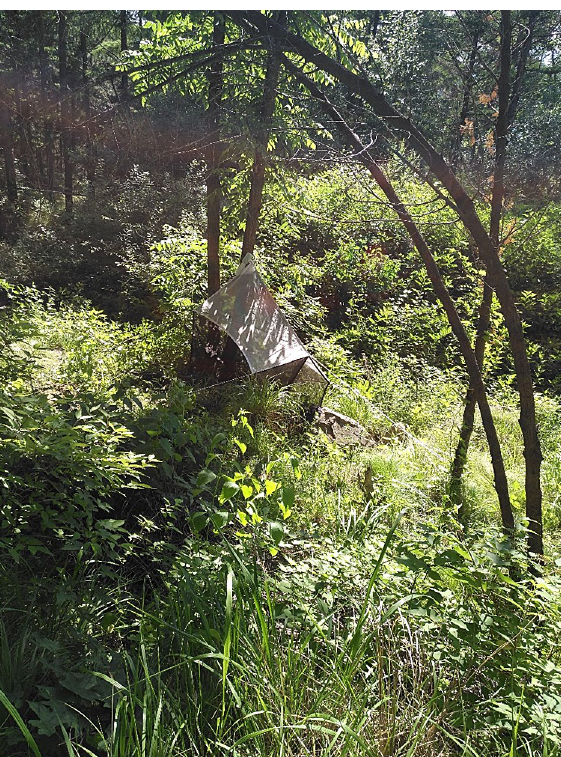
Figure 1. The Malaise trap deployed in the collecting